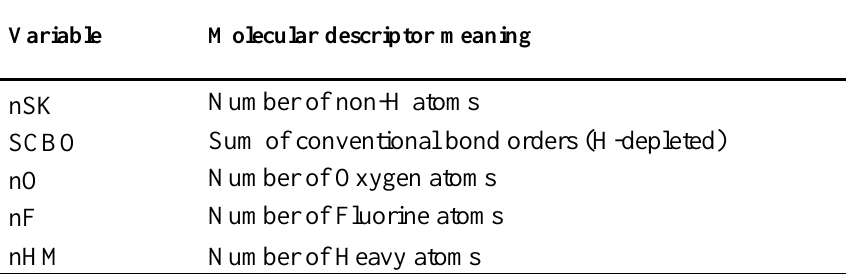
Table 1. The molecular descriptors of Eq. (2) and their meaning .